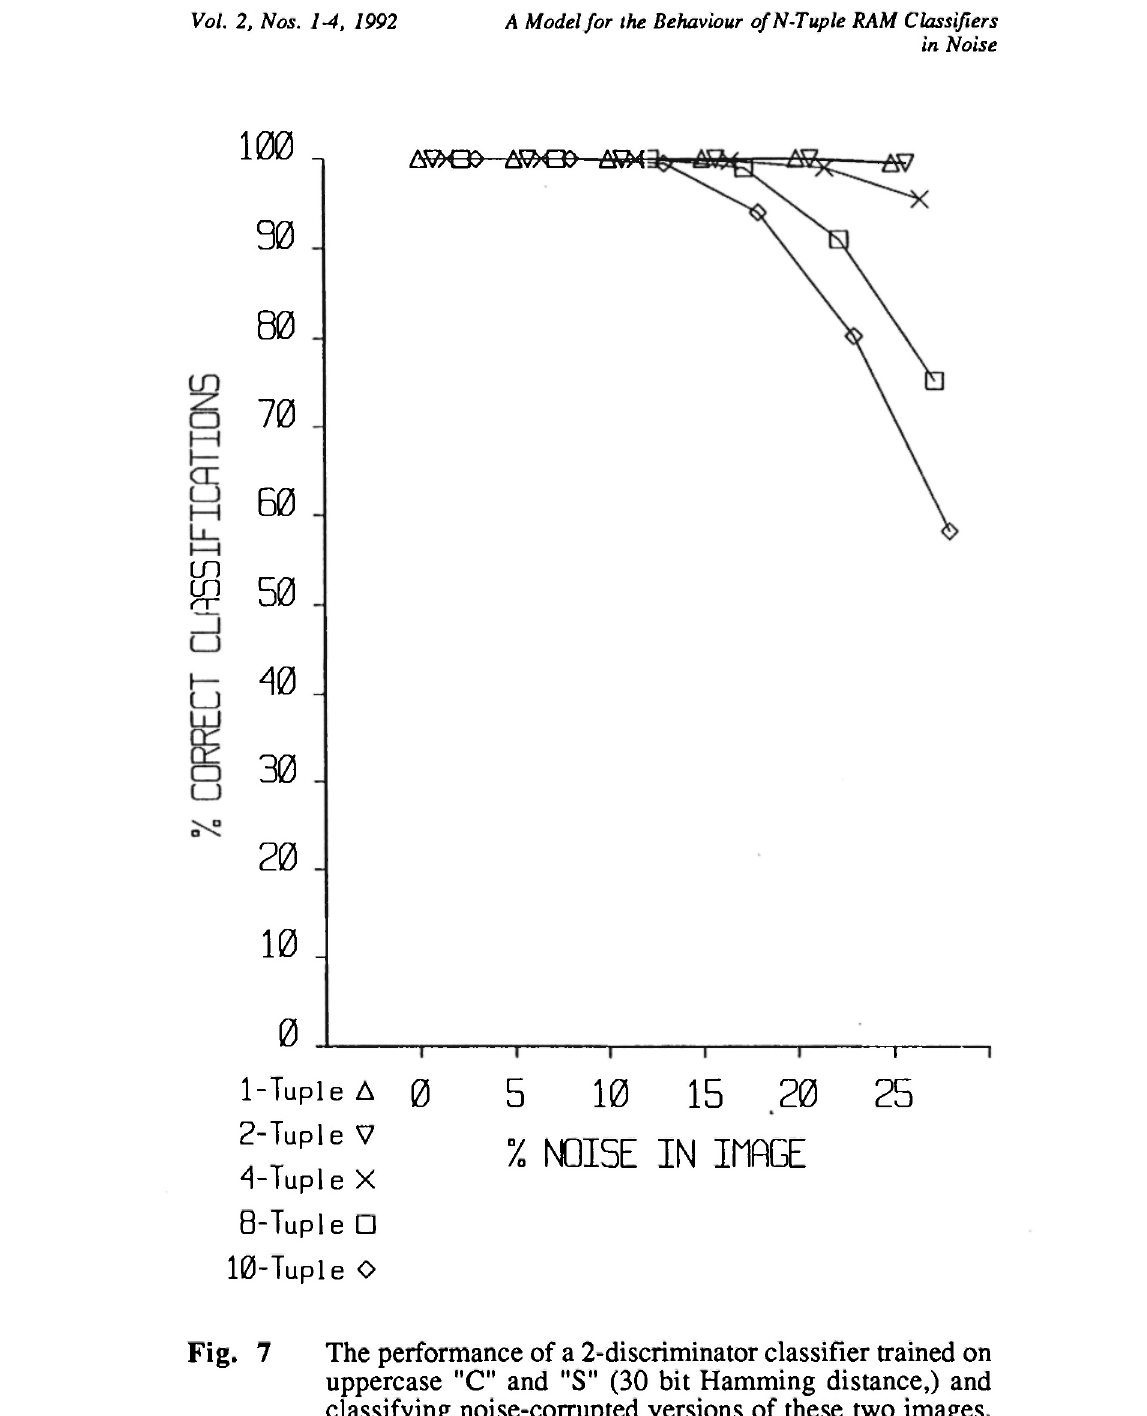
Fig. 7 The performance of a 2-discriminator classifier trained on uppercase "C" and "S" (30 bit Hamming distance,) and classifying noise-corrupted versions of these two